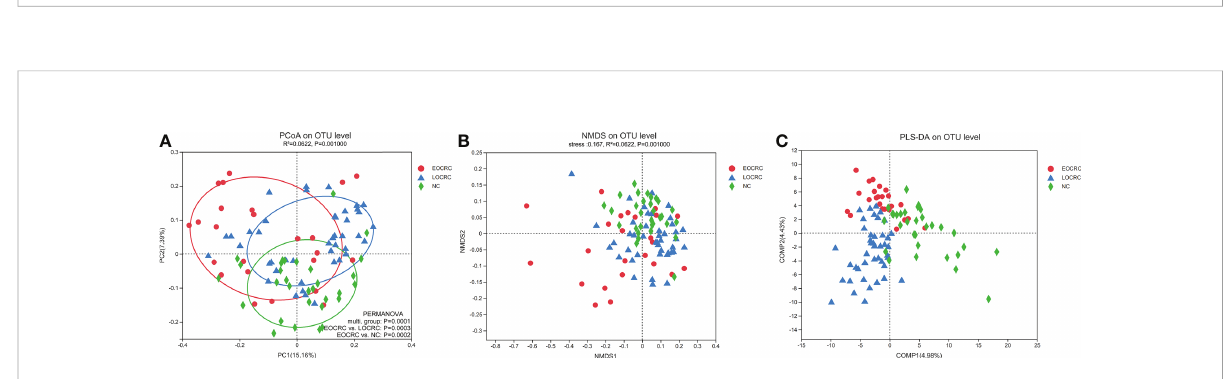
FIGURE 2 Beta diversity analysis of gut microbiota among the three groups. (A) Beta diversity calculated by PCoA of unweighted UniFrac distances and PERMANOVA. (B) The non-metric multidimensional scaling (NMDS) analysis results at the OUT level based on unweighted UniFrac distances. (C) Signi fi cant deviations were observed in the three sample groups at the OTU level.